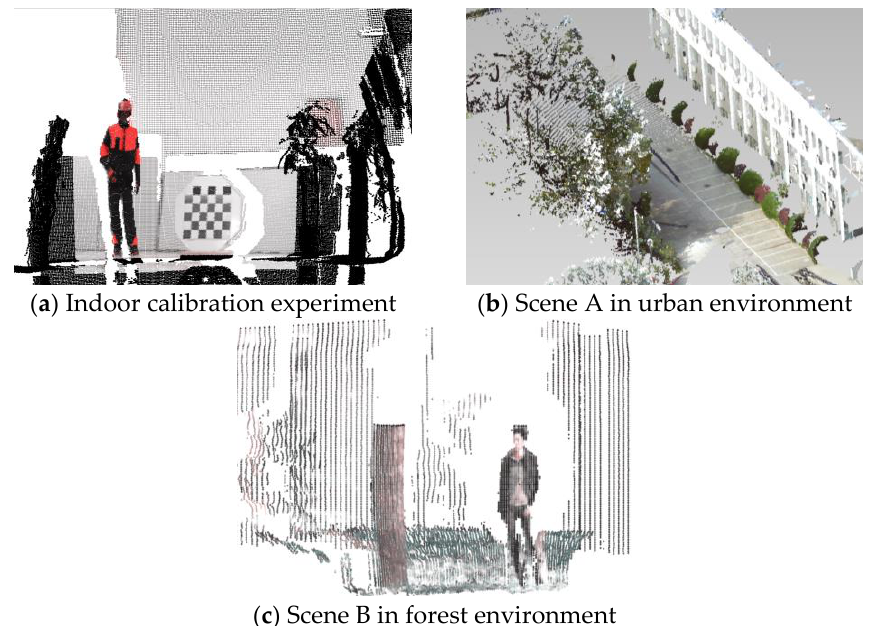
Figure 9. ( a ) Joint calibration experiment was accomplished in indoor scene with well fusion performance; ( b ) HFD of Scene A were obtained in urban environment without extra calibration process; ( c ) HFD were obtained in Scene B of forest environment at extreme distances.